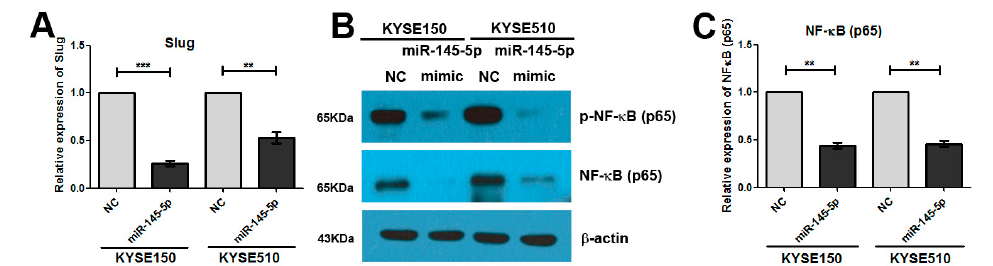
Figure 3. Overexpression of miR-145-5p inhibited the transcription of Slug via the NF- κ B signaling pathway. ( A ) The mRNA expression of Slug was determined by real-time PCR ( n = 3); ( B ) The protein levels of NF- κ B (p65) and p- NF- κ B (p65) were measured by Western blotting assay ( n = 3); ( C ) The mRNA expression of NF- κ B (p65) was determined by real-time PCR ( n = 3). NC: non-specific negative control. Three independent experiments were performed. ** p < 0.01; *** p < 0.001. Sp1 could transcriptionally regulate the expression of NF- κ B ( p65 ), and miR-145-5p could target inhibited the protein and mRNA expressions of Sp1 (Figure 4A–C). Knockdown of Sp1 in KYSE150 and KYSE 510 cells significantly reduced the levels of CCNA2 , CCND1 and CCNE1 (Figure 4D–F).